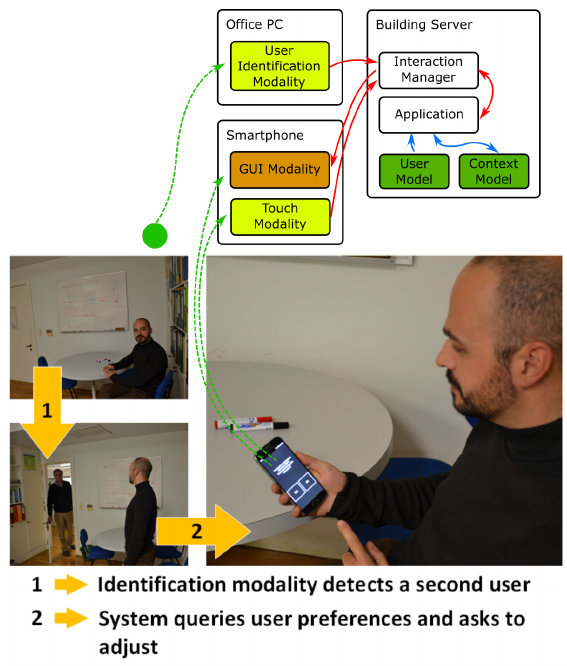
Figure 10. Illustrative scenes and framework components diagram for Proof-of-Concept 2—Meeting. A new occupant arrives at the office, for a meeting, and has different room temperature preferences than the first occupant (owner of office) who receives a notification to change temperature settings, if he